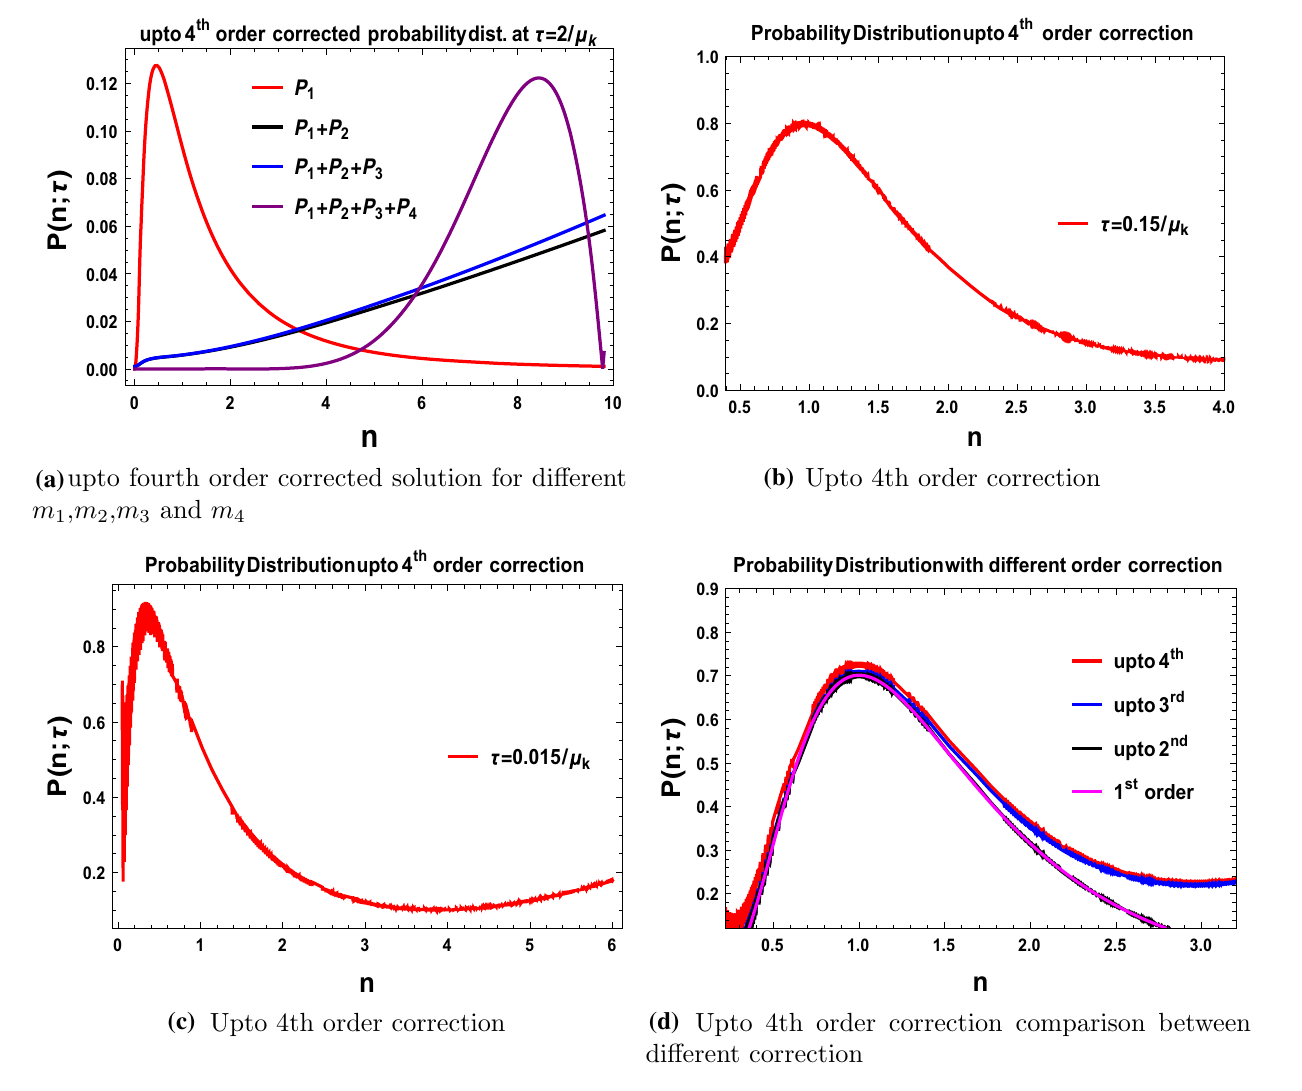
Fig. 47 Fourth order corrected probability distribution for different m 4 , m 3 , m 2 and m 1 = 2 with previously mentioned initial conditions Fig. 48 Time